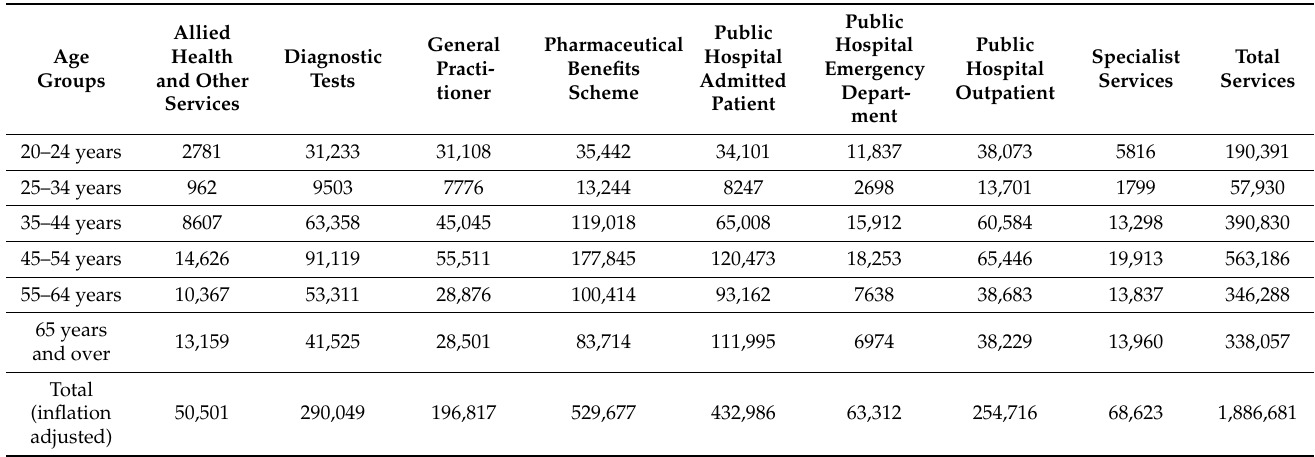
Table A2. Extra costs incurred due to LHL for people diagnosed with Musculoskeletal disorders in the Blacktown LGA (Domain